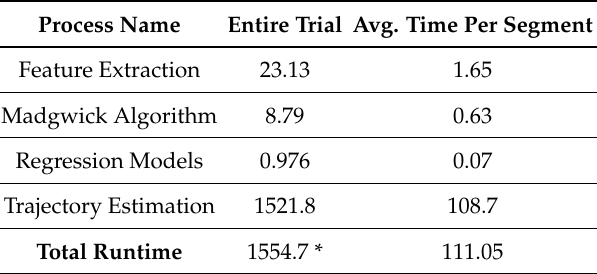
Table 13. Trial #7: Algorithm runtime (s) for two-minute trajectory